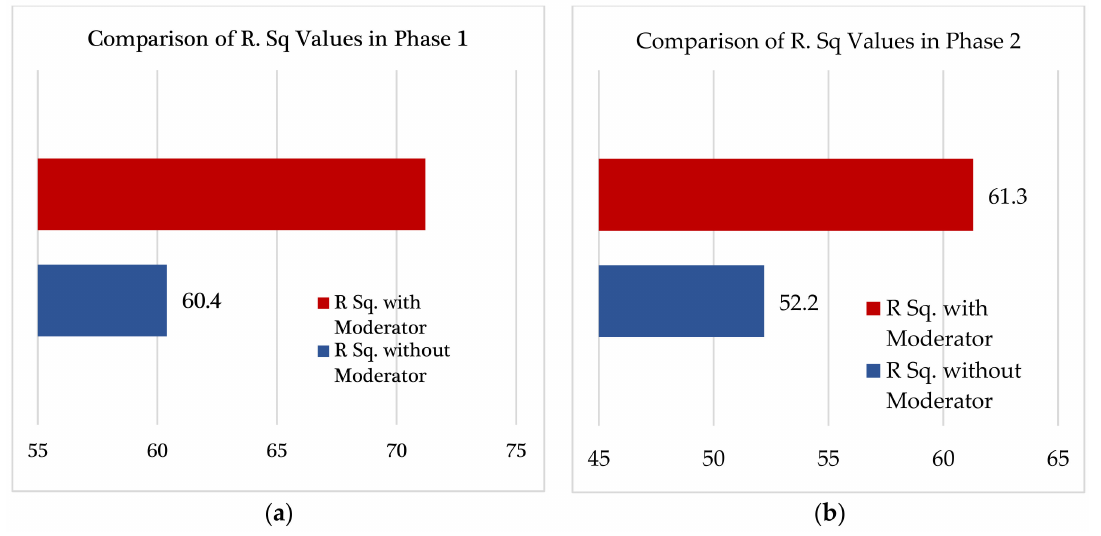
Figure 6. ( a ). Comparison of R-Square in Phase 1. ( b ). Comparison of R-Square in Phase